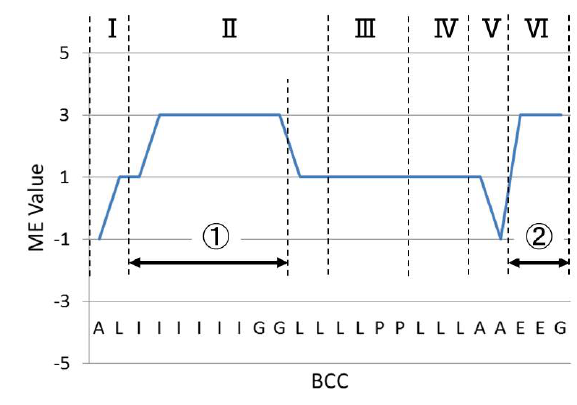
Figure 3. Participant A’s BCC and ME value changes